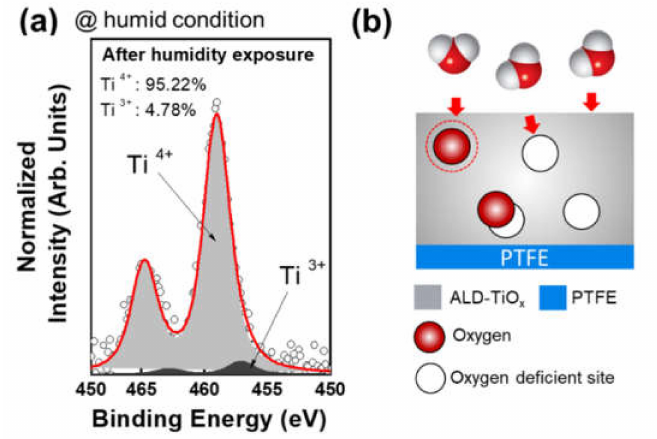
Figure 5. Change in the chemical bonding state after humidity exposure and relevant mecha- nism. ( a ) Deconvoluted Ti 2 p spectrum after moisture exposure with RH 99% at room temperature. ( b ) Schematic illustration of humidity passivation mechanism according to the oxygen deficient sites.